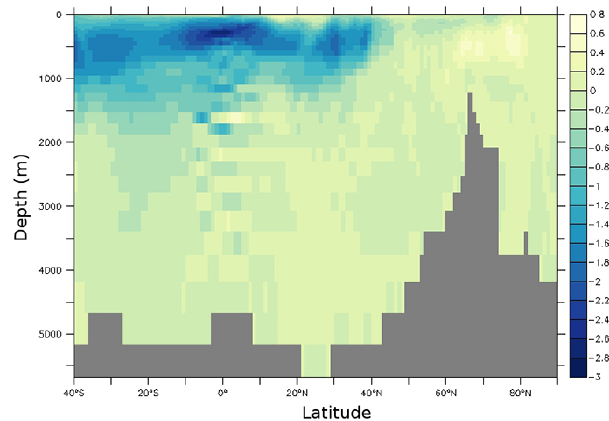
Figure 11. Anomalous Atlantic meridional overturning circulation (AMOC) between Exp. 3a and 3b. Units are Sv = 10 6 m 3 s − 1